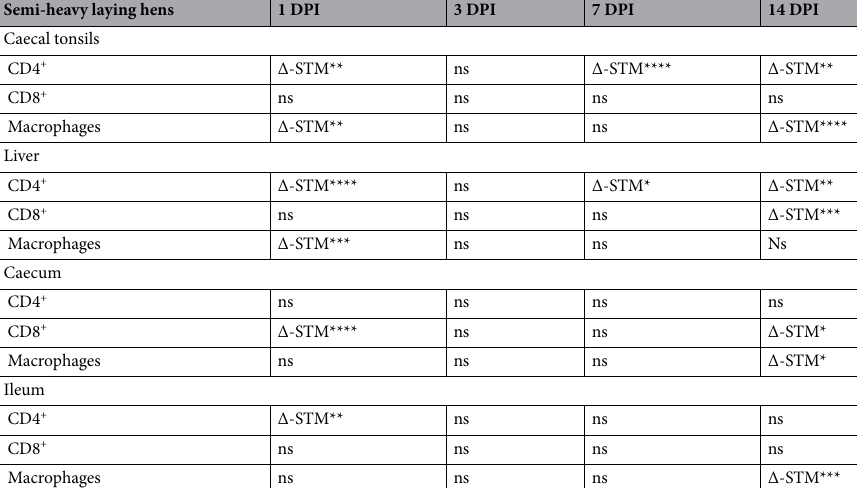
Semi-heavy laying